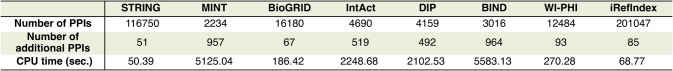
Summary of eight databases and results on MinPPI by GreedyMinPPI.